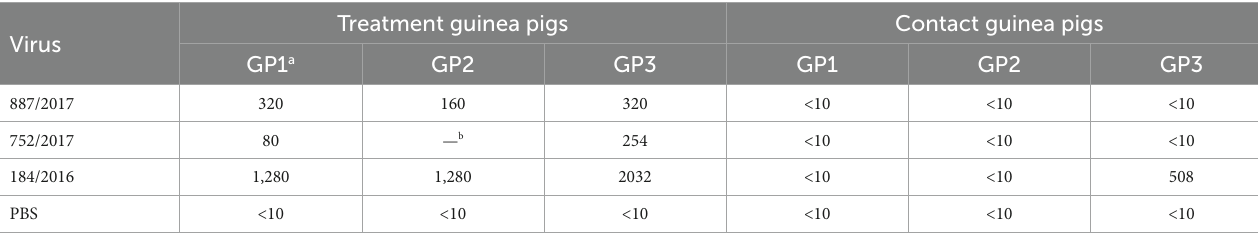
Treatment guinea pigs